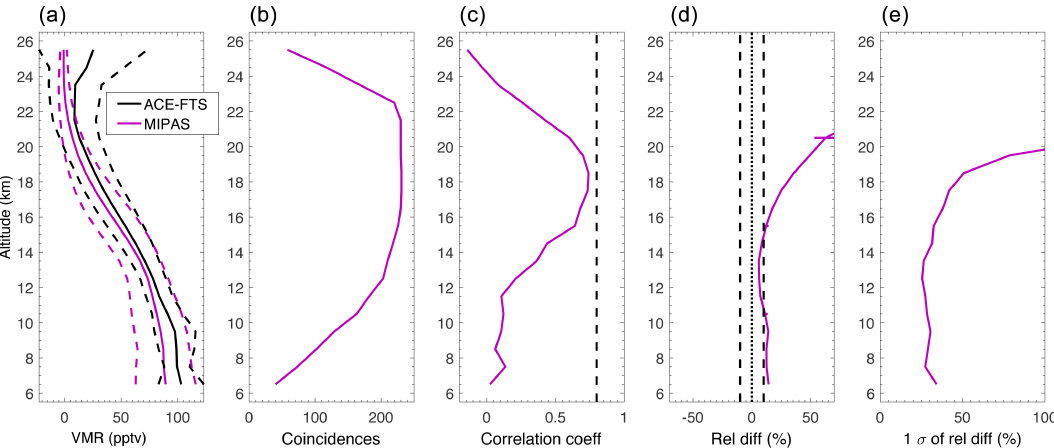
Figure 13. Comparison of MIPAS Envisat and version 3.5 ACE-FTS CCl 4 . (a) Mean profiles of all coincident profiles (black: ACE-FTS; magenta: MIPAS). Dashed lines show the standard deviations of the mean profiles. (b) Number of coincident points per altitude. (c) Corre- lation coefficient of the mean profiles. (d) Relative differences of the mean profiles. (e) One standard deviation of the relative differences of the mean profiles.